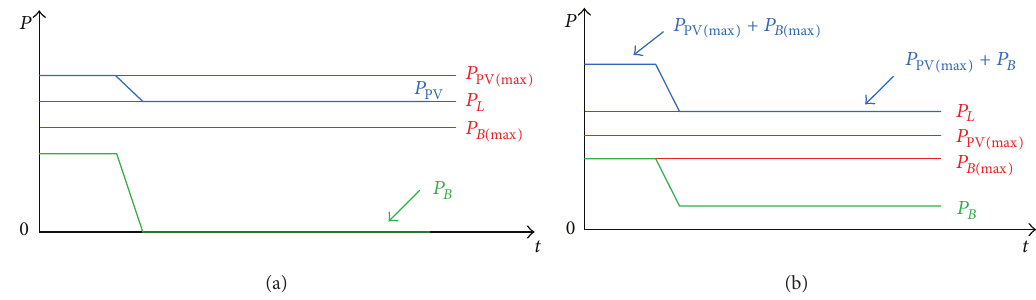
≥ 𝑃 𝑃 < 𝑃 𝐿 and 𝐵( max ) 𝐿 and (b) under PV ( max )